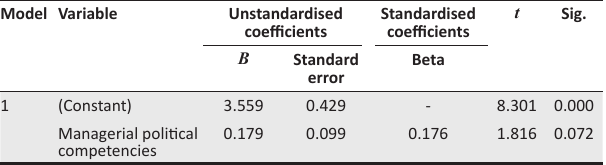
TABLE 5 : Regression results of managerial political competencies and